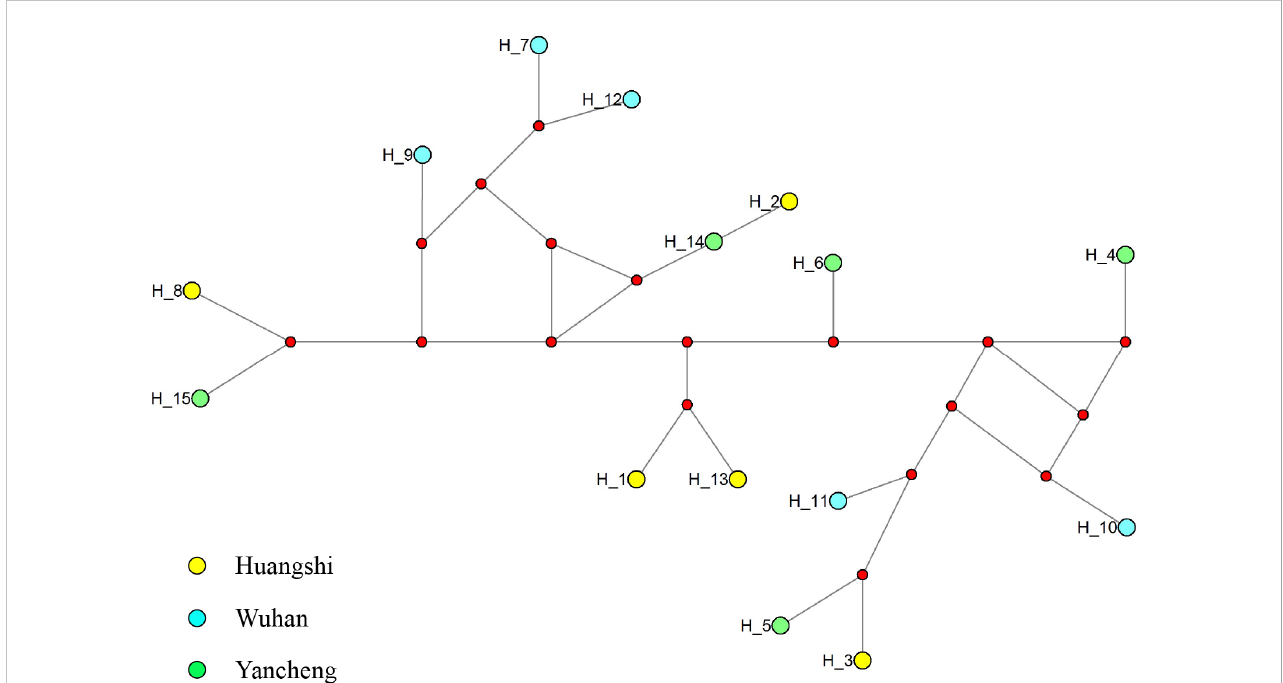
FIGURE 6 Median-joining haplotype network of Rpb1 sequences from Neo fl abelliforma dubium n. sp. isolates. Yellow, blue and green circles represent haplotypes obtained from different locations (Huangshi, Wuhan and Yancheng, respectively). Red circle indicates median vectors.